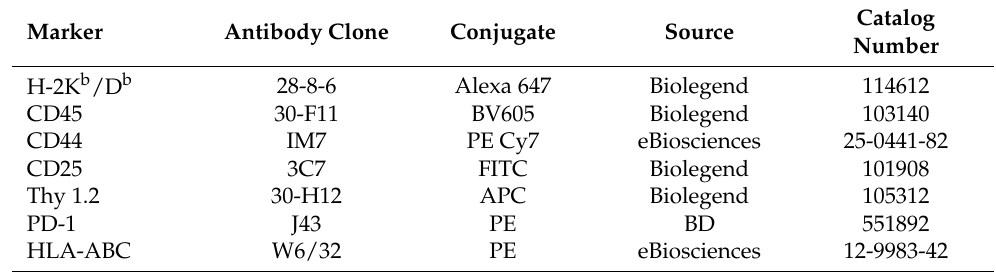
Table 4. Antibodies used for flow